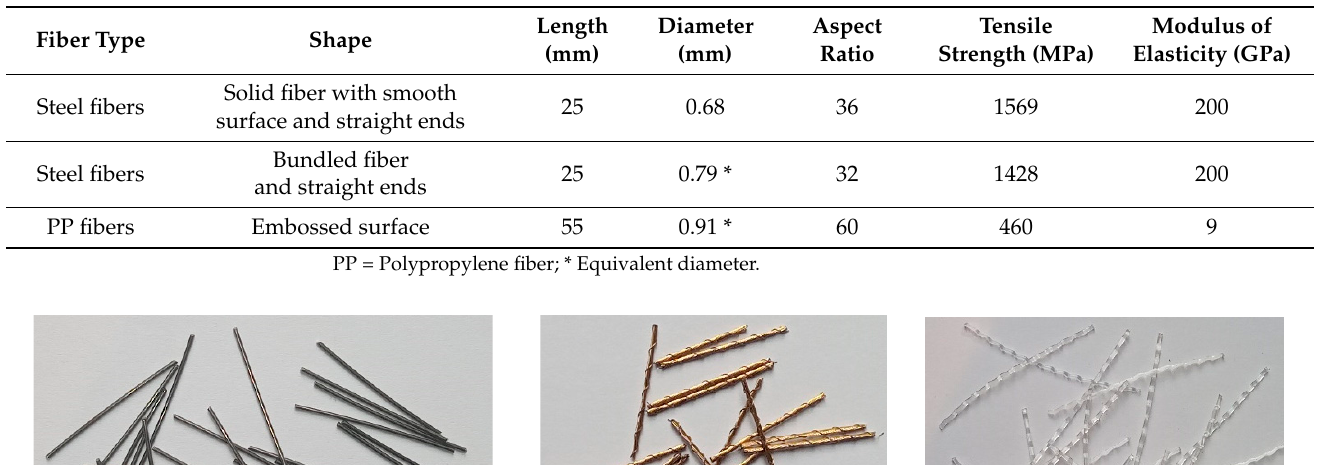
Table 2. Properties of used fibers.